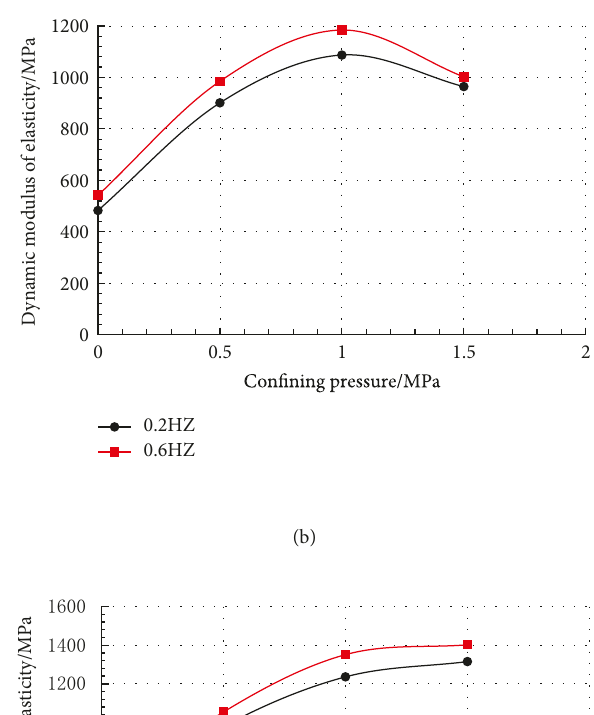
Figure 10: Relation curve of dynamic modulus of elasticity and confining pressure. (a) T